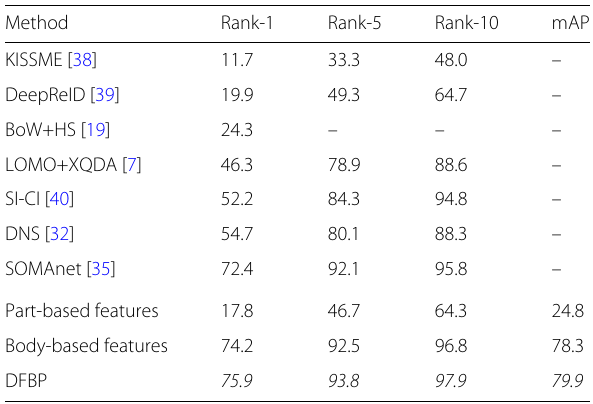
where p i ( i = 1, 2, ..., n ) represents the feature of the i -th subregion in a pedestrian image, α i ( i = 1, 2, ..., n ) is